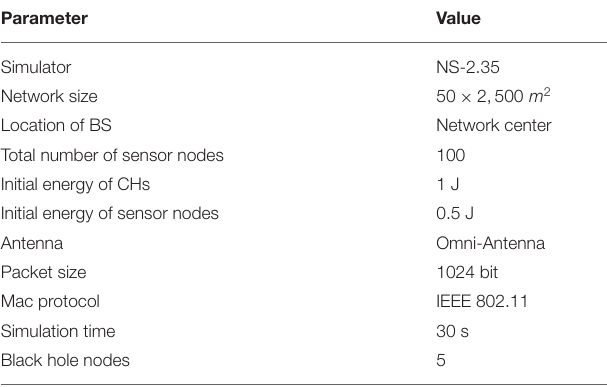
SMEER and LEACH-C in terms of end-to-end delay, throughput,